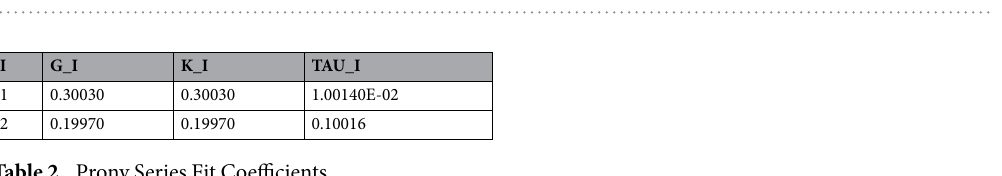
Table 1. Hyperfoam Model Coefficients.